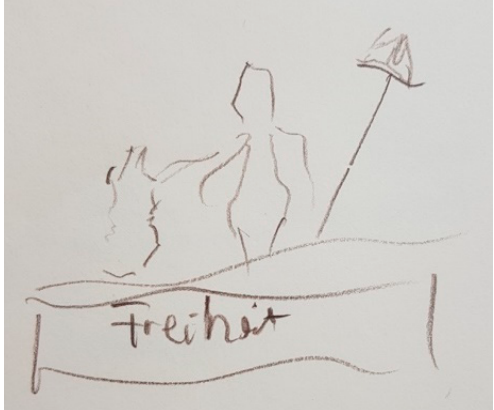
Figure 9. P8’s perception of PD. The word “Freiheit” in German means freedom. “ There’s glue on your feet. You want to go somewhere, and you can’t. In your head dopamine is missing ”.